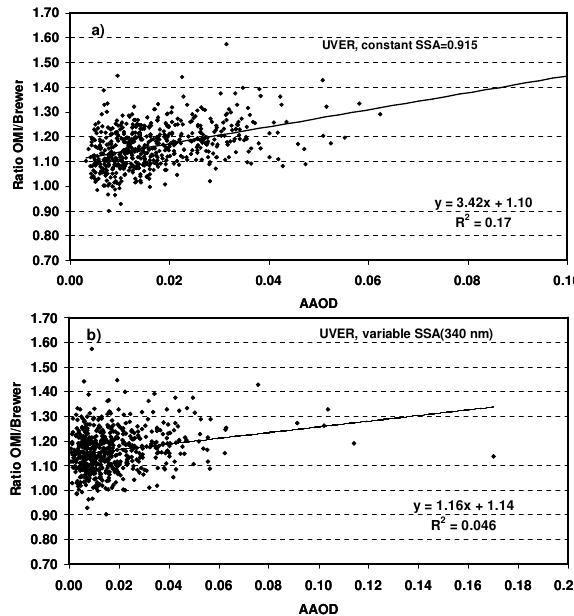
Figure 9 Figure 9